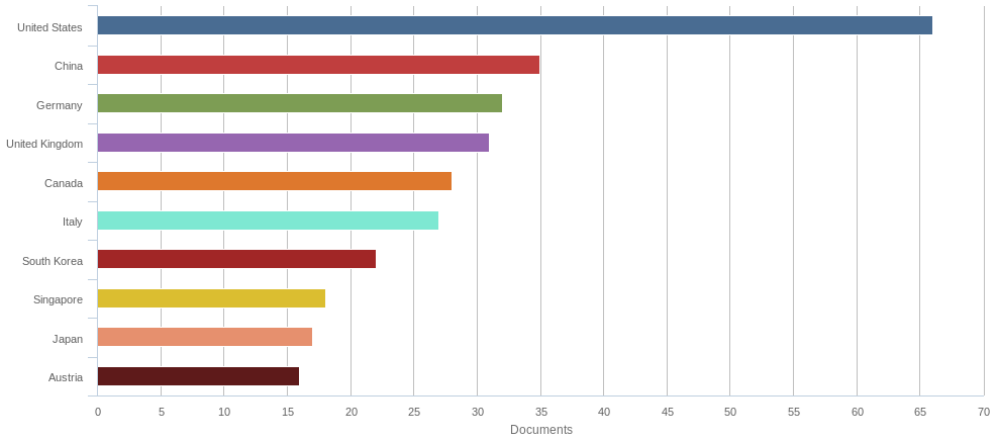
Figure 2. Distribution of number of articles per